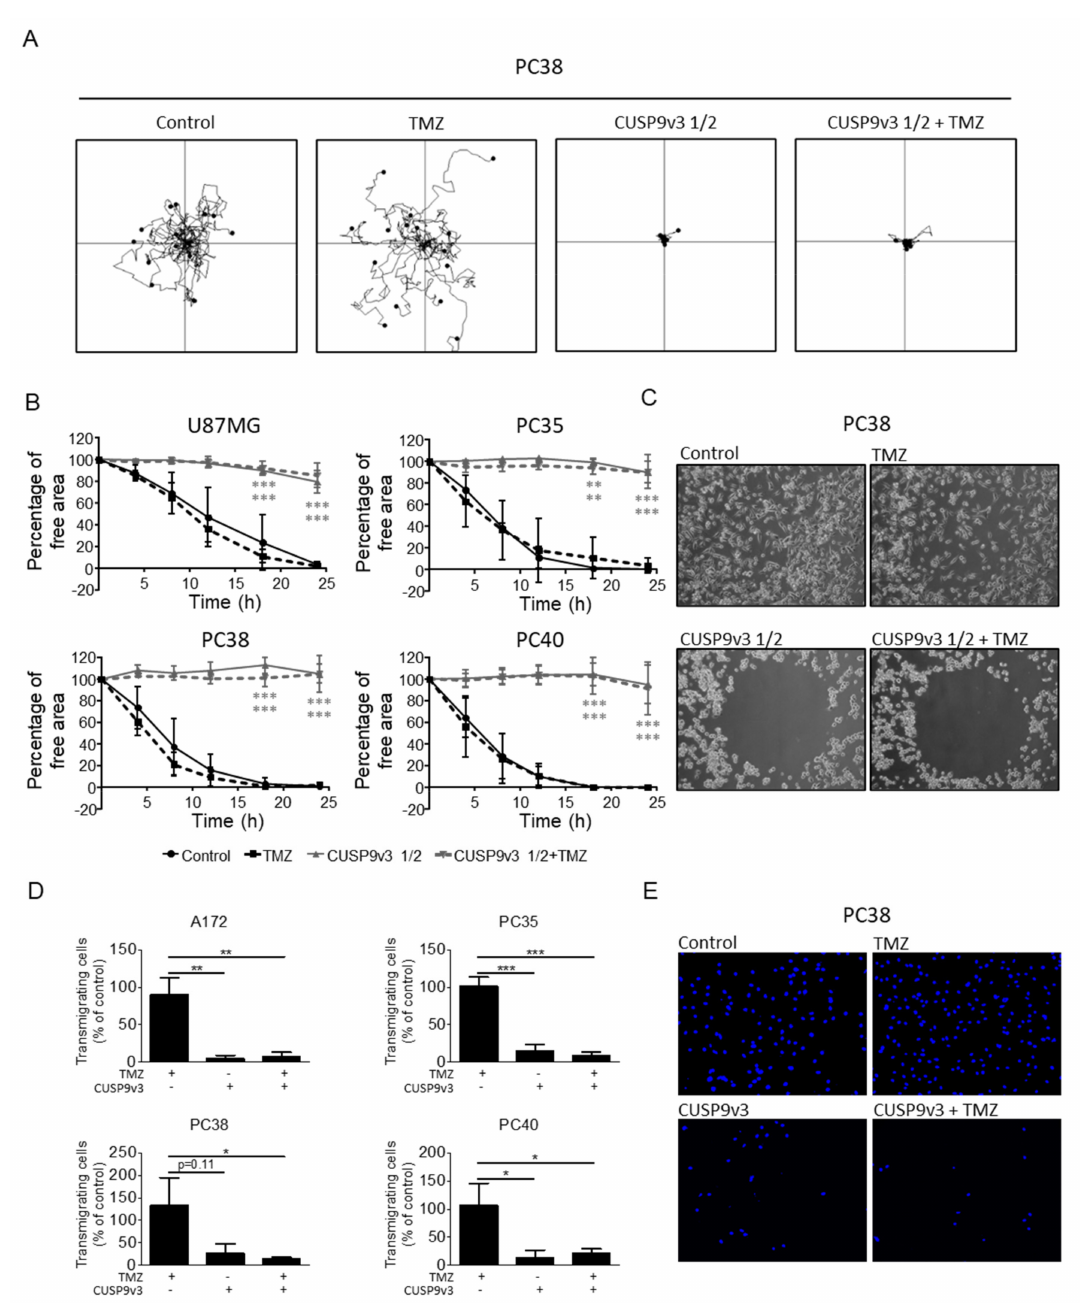
Figure 3. ( A ), PC38 cells were treated for 24 h as indicated. During this period, microscopic images were taken at 10 × magnification every 30 min. Single-cell tracking was performed using the MtrackJ software. Wind-rose plots displaying the paths of 15 single cells per treatment condition during the 24 h observation period are shown. The tracks are zeroed to start from the same initial position. ( B ), U87MG, PC35, PC38 and PC40 cells were treated as indicated. The percentage of free area was calculated as described in Materials and Methods. Data points: mean. Bars: Standard deviation (SD). ** p < 0.01, *** p < 0.005 versus TMZ. ( C ), Representative microphotographs of PC38 cells treated for 18 h as indicated. Magnification 10 × . ( D ), A172, PC35, PC38 and PC40 cells were seeded onto Transwell ® membranes and treated as indicated. After 8 h, representative microphotographs were taken at 10 × magnification and transmigrating cells were counted (in total 9 high-power fields per treatment condition). Columns: mean. Bars: SD. * p < 0.05, ** p < 0.01, *** p < 0.005. ( E ), Representative microphotographs of transmigrating PC38 cells treated for 8 h as indicated prior to staining with DAPI and microscopic imaging with 10 ×